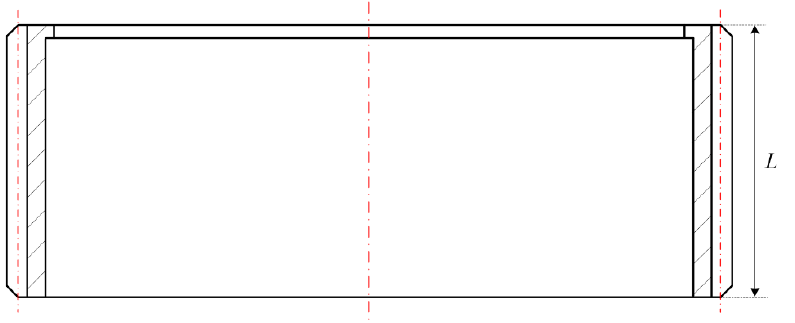
Figure 2. Structure of the disposable flexible wheel.